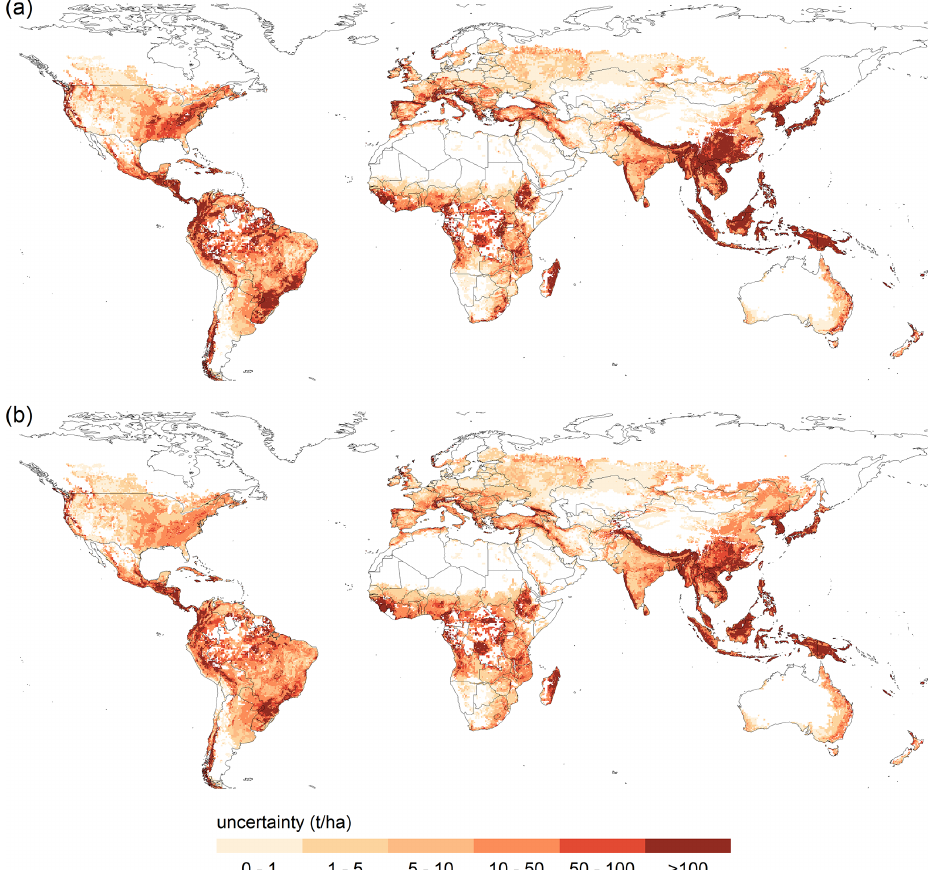
Figure 3. Water erosion uncertainty due to (a) field management assumptions and (b) water erosion equations.